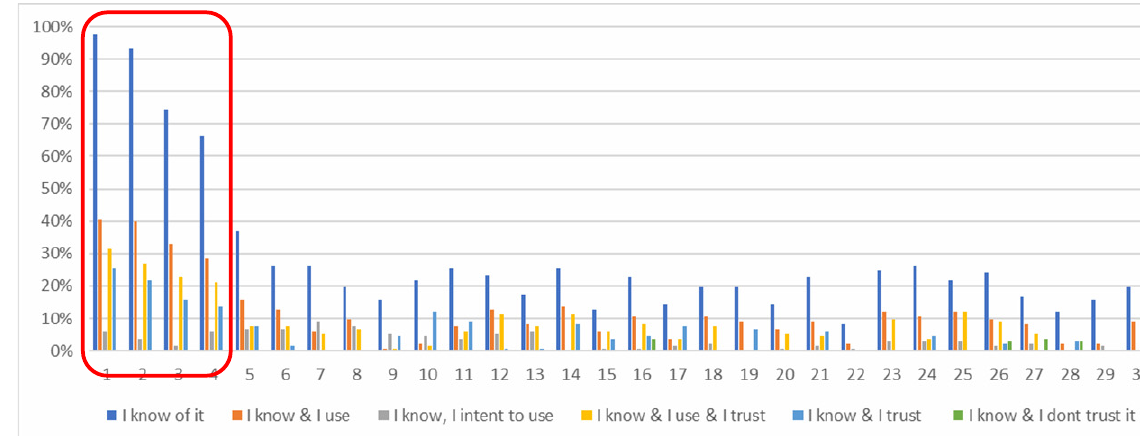
Figure 2. Number of answers by application